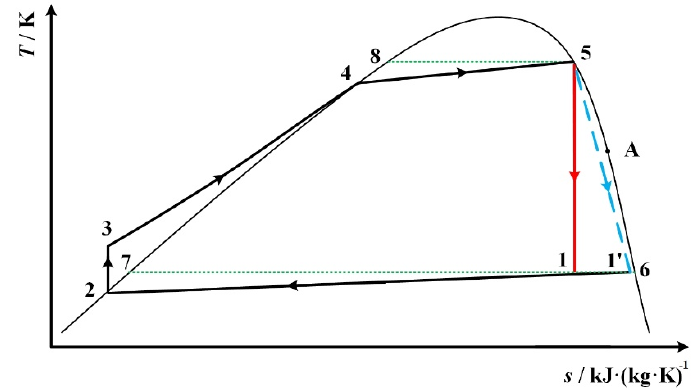
Figure 12. Point A with the longest distance between the outlet of the single screw expander and the saturated vapor curve.